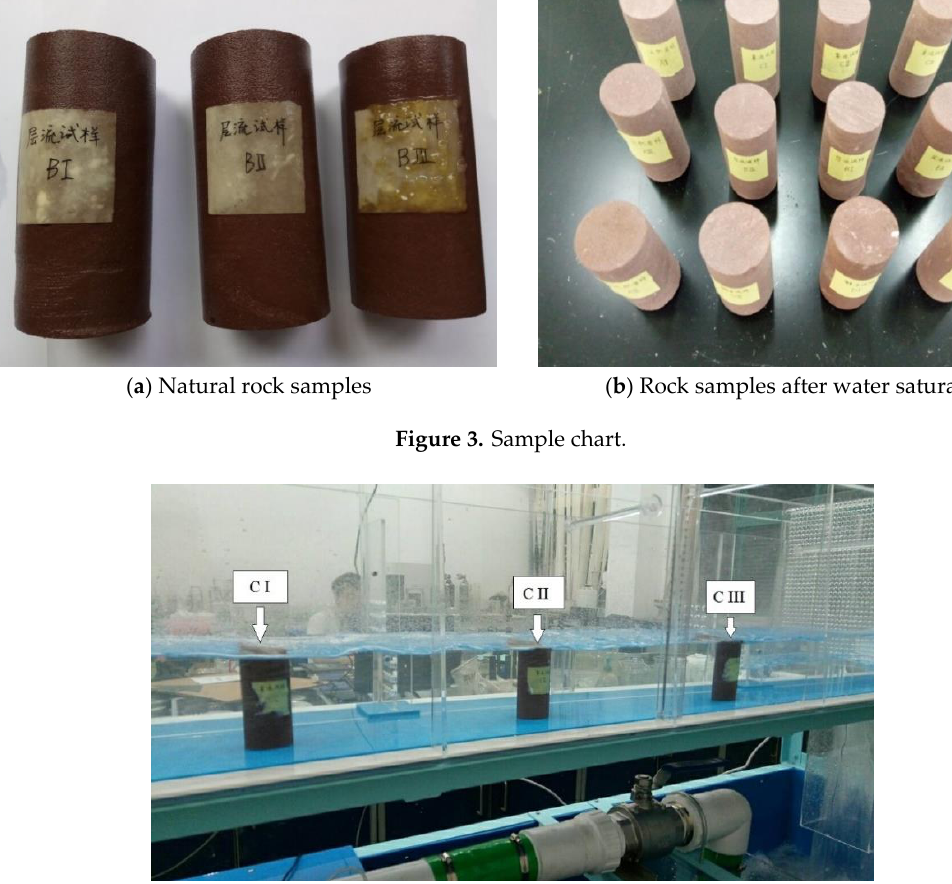
Figure 4. Turbulence test state diagram.